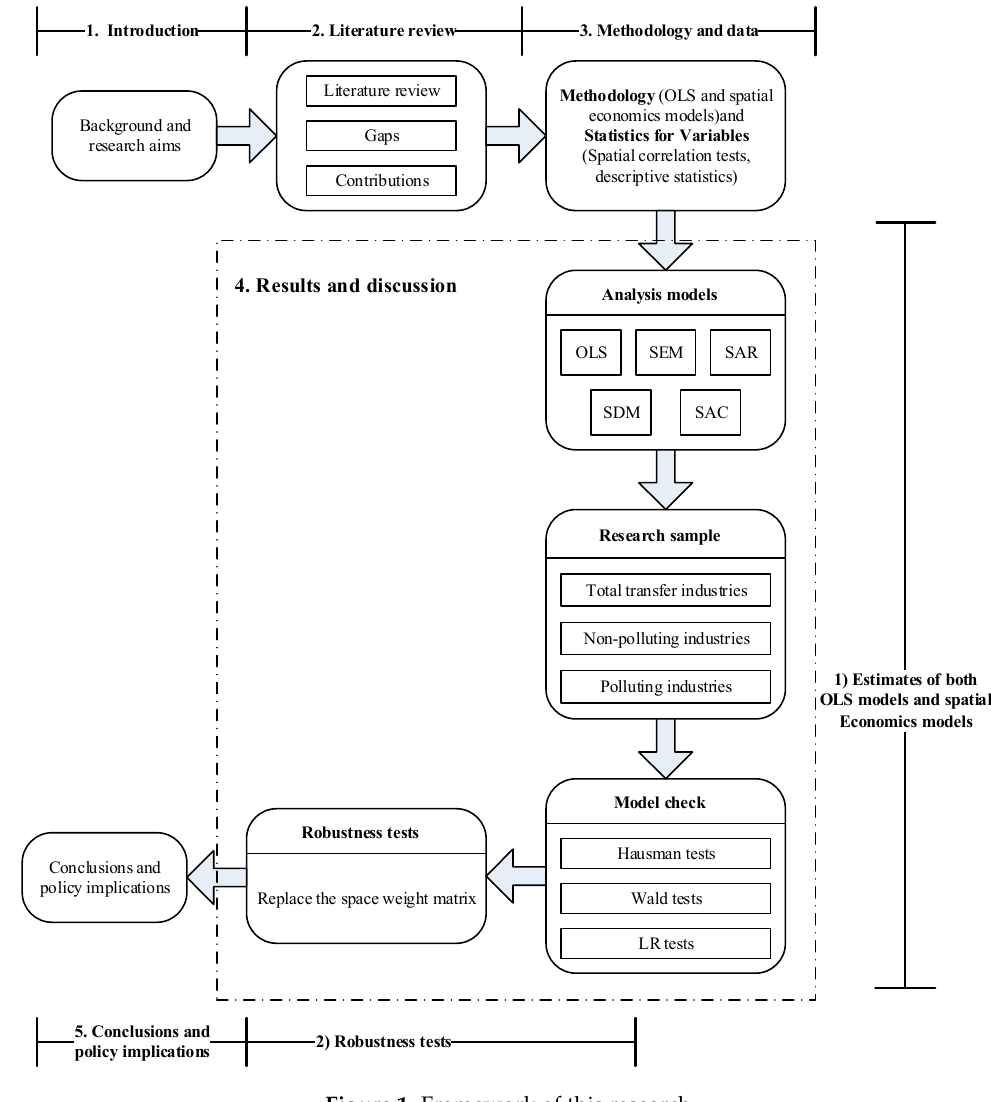
Figure 1. Framework of this research.